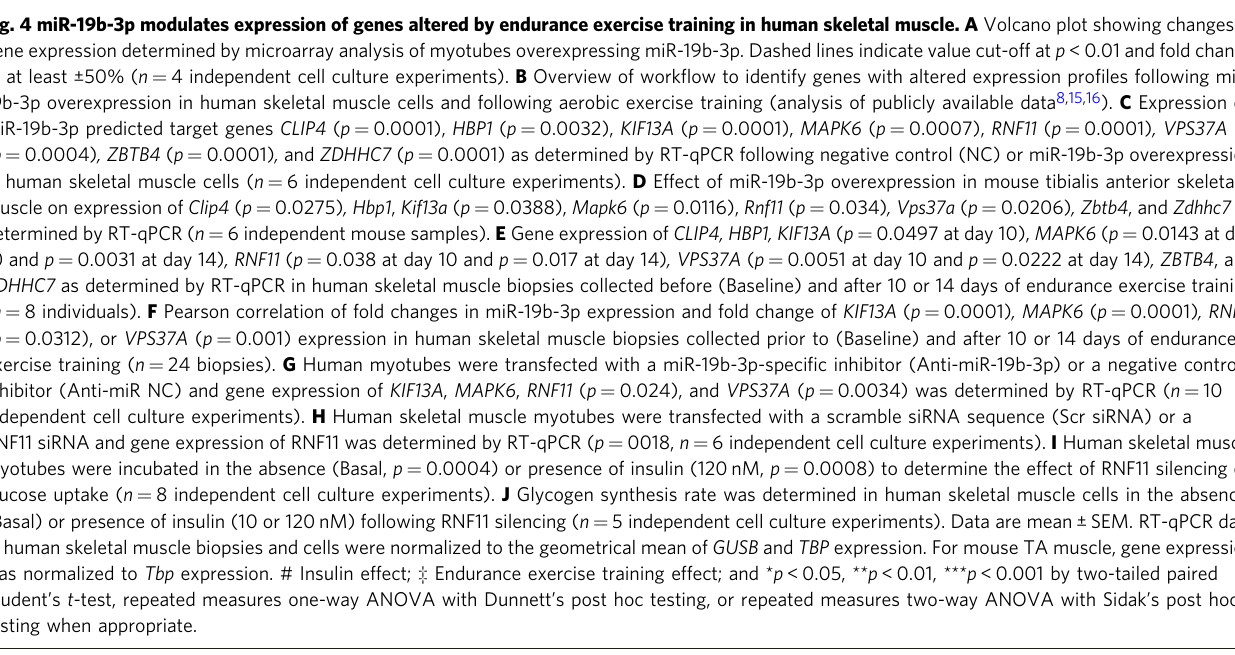
Fig. 4 miR-19b-3p modulates expression of genes altered by endurance exercise training in human skeletal muscle. A Volcano plot showing changes in gene expression determined by microarray analysis of myotubes overexpressing miR-19b-3p. Dashed lines indicate value cut-off at p < 0.01 and fold change of at least ±50% ( n = 4 independent cell culture experiments). B Overview of work fl ow to identify genes with altered expression pro fi les following miR- 19b-3p overexpression in human skeletal muscle cells and following aerobic exercise training (analysis of publicly available data 8,15,16 ). C Expression of miR-19b-3p predicted target genes CLIP4 ( p = 0.0001), HBP1 ( p = 0.0032), KIF13A ( p = 0.0001), MAPK6 ( p = 0.0007), RNF11 ( p = 0.0001) , VPS37A ( p = 0.0004) , ZBTB4 ( p = 0.0001) , and ZDHHC7 ( p = 0.0001) as determined by RT-qPCR following negative control (NC) or miR-19b-3p